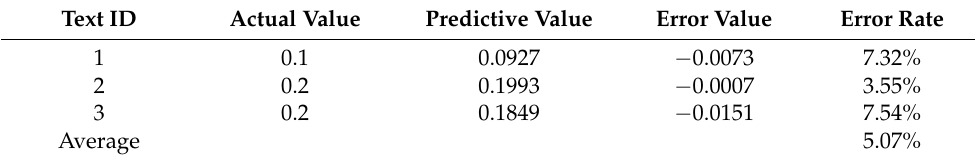
Figure 6. Prediction accuracy of the monitoring model.